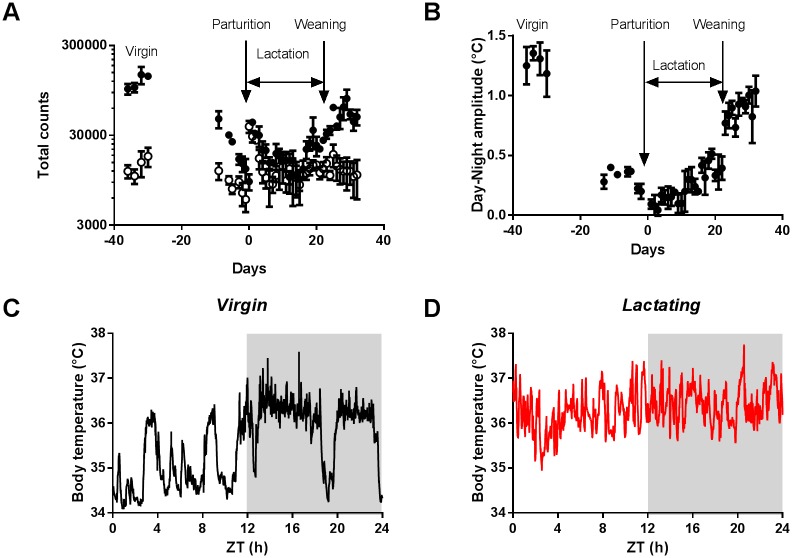
Longitudinal telemetric monitoring of locomotor activity and body temperature in female mice.A. Daytime (open circles) and night-time (closed circles) counts in locomotion throughout a reproductive cycle. B. Average day-night amplitude in body temperature throughout a reproductive cycle. (mean±sem, n = 3 mice; temperature amplitudes were significantly smaller every days of lactation as compared to the period before mating, F(21, 42) = 9.333, p<0.0001 2-way ANOVA Tukey's multiple comparisons test). C and D. Representative example of 24-hour variations in body temperature, recorded in a same mouse before mating (C) and during lactation (D). ZT0 defined as time of lights on.